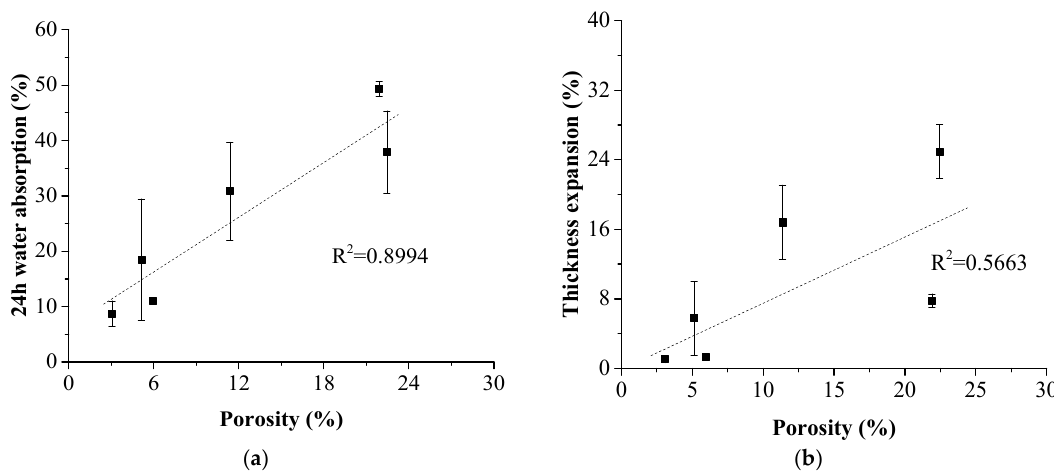
Figure 10. Relationship between porosity and water absorption of the laminated composites. ( a ) 24-h water absorption; ( b ) thickness expansion.